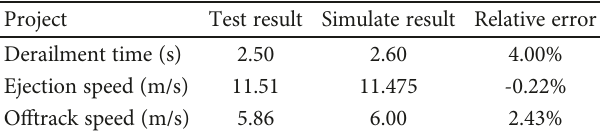
Figure 9: Side view of aircraft ’ s surface